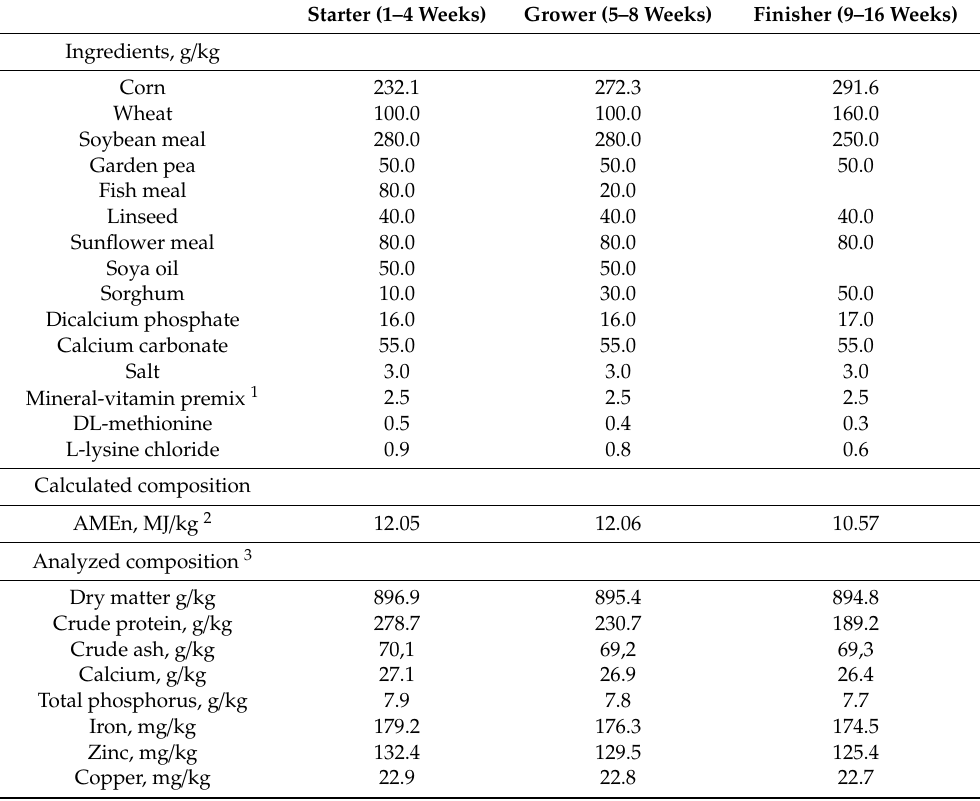
Table 1. Composition and nutritive value of reared pheasant diet.